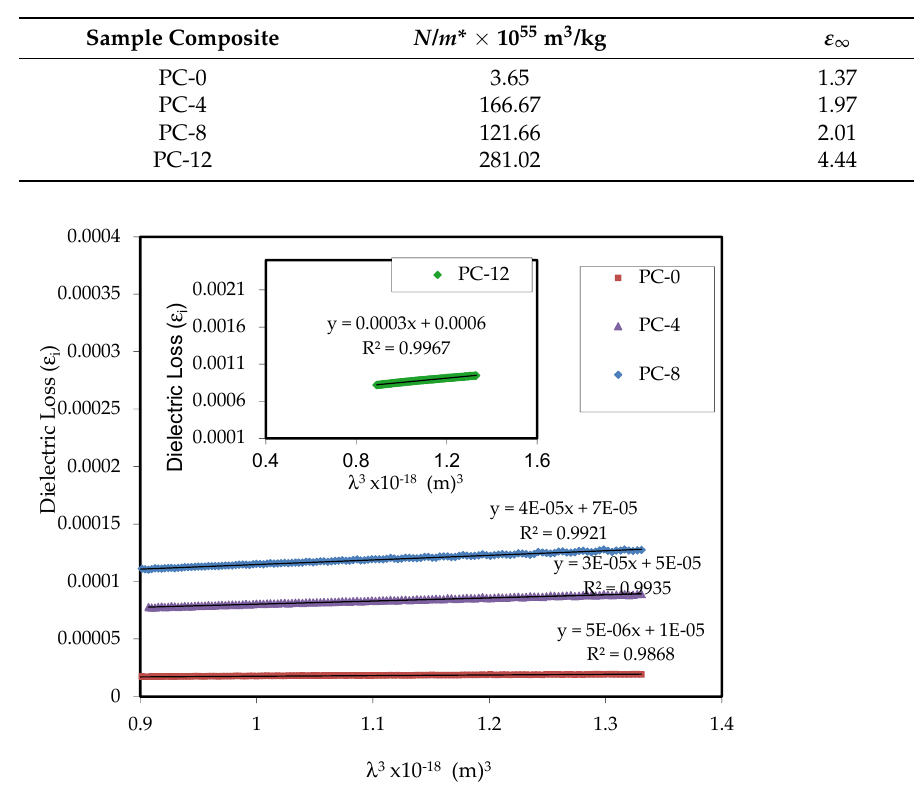
Figure 12. Plots of 𝜀 (cid:3036) versus (cid:2871) for the systems.